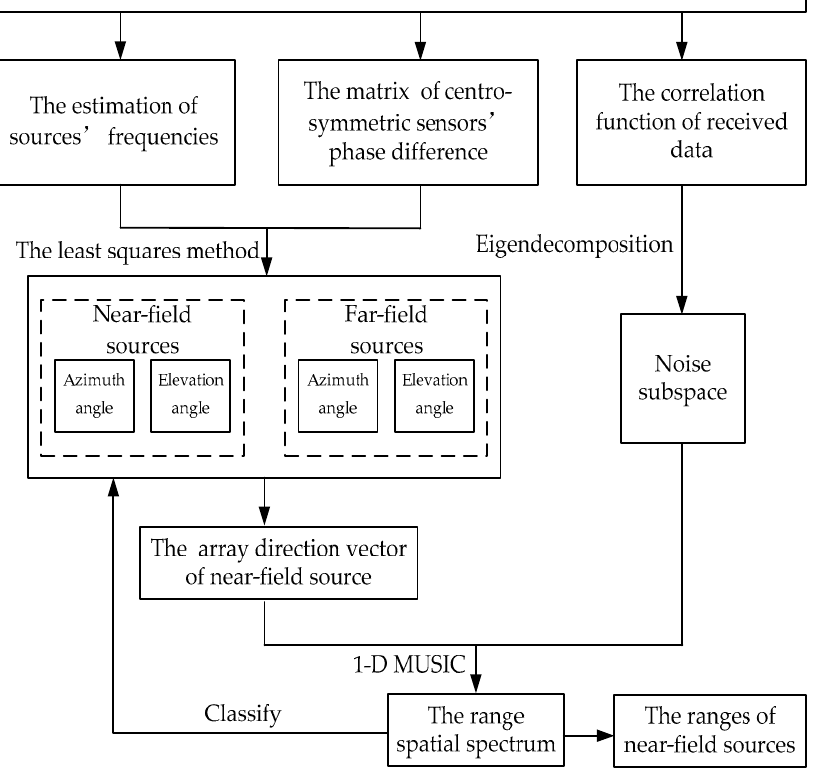
Figure 3. Flow chart of the proposed algorithm.